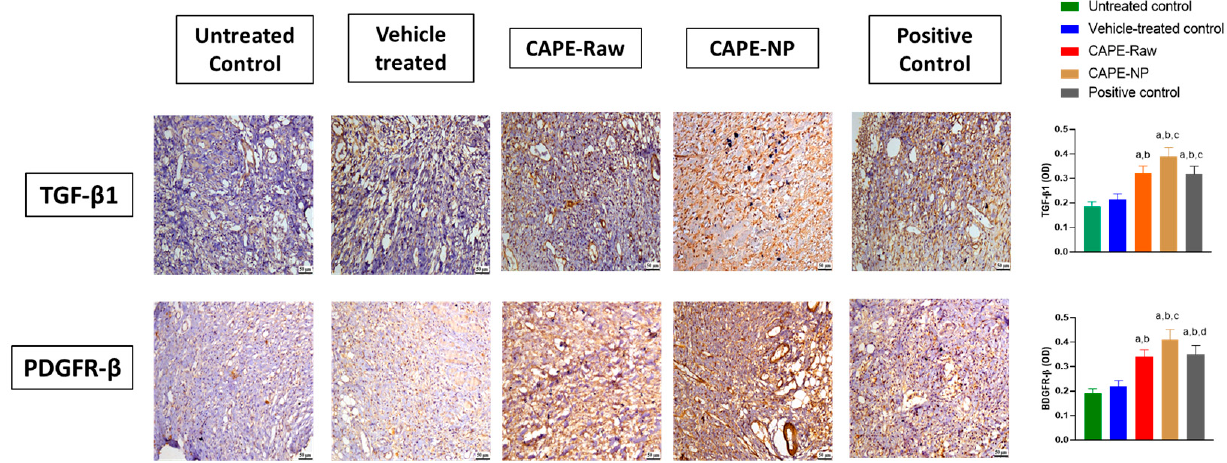
Figure 8. Effect of CAPE-NPs on TGF- β (upper row), and PDGF-B (lower row) expression in diabetic rat skin wounds on day 14. Data are expressed as mean (n = 6) ± SD. (a) Significantly different from untreated control at p < 0.05, (b) significantly different from vehicle-treated control at p < 0 .05, (c) significantly different from CAPE-raw at p < 0 .05, and (d) significantly different from CAPE-NP at p < 0 .05.